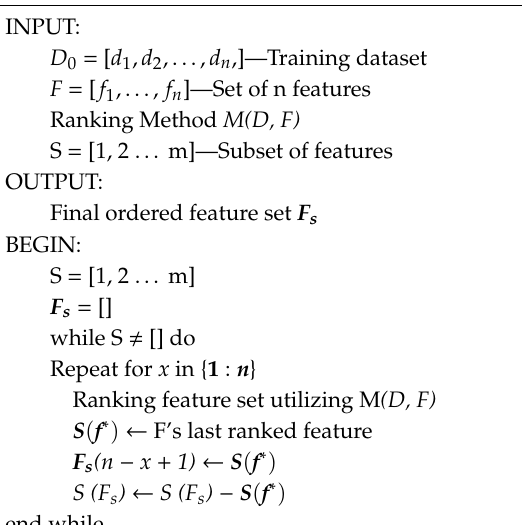
Algorithm 2 RF-RFE wrapper-based feature selection